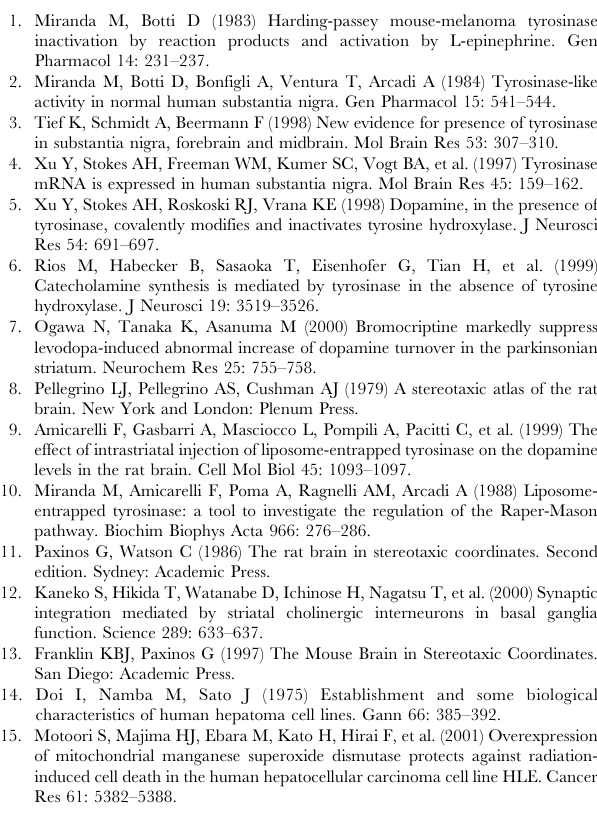
Figure S4 TH-IR in the right lateral striatum (A) and the substantia nigra (B) in hemi-parkinsonian albino mice at 88 days after intrastriatal transplantation of melano- cytes obtained from albino (ICR) or black (C57BL) mice. Quantitative data of integrated density of TH-IR in the right lateral striatal area around the transplant (C) and substantia nigra pars compacta (D). Values are means 6 SEM (n= 3–4). ** p , 0.0005 vs. intact control side of each treated group. ++ p , 0.0005 vs. side- and treatment-matched sham-operated group. Movie S1 Effects of intrastriatal injection of tyrosinase on apomorphine-induced rotation behavior in hemi- parkinsonian rats. Representative movie of behavior at 10 min after apomorphine injection (0.1 mg/kg, s.c.) at 4 days before (pre- lipofection) and at 3 days after lipofection of liposome-entrapped into the right lateral striatum of hemi-parkinsonian rats or sham- operated